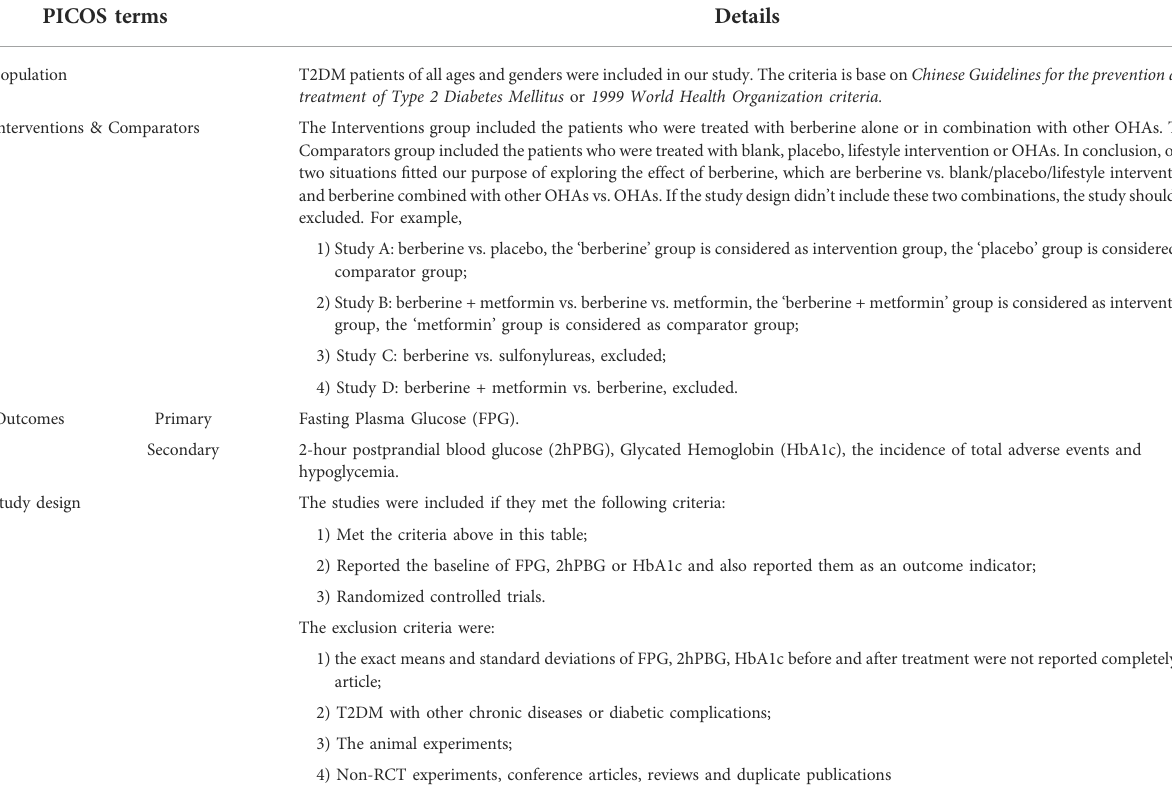
TABLE 1 The PICOS of our